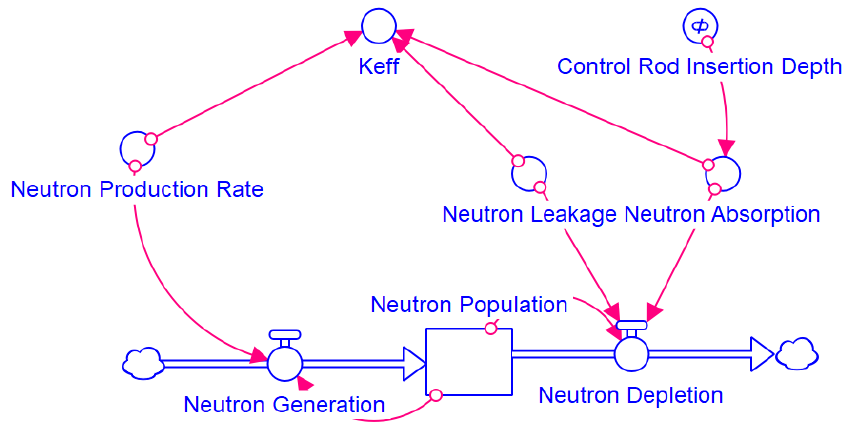
Fig. 28. Stock-and-flow diagram of a nuclear